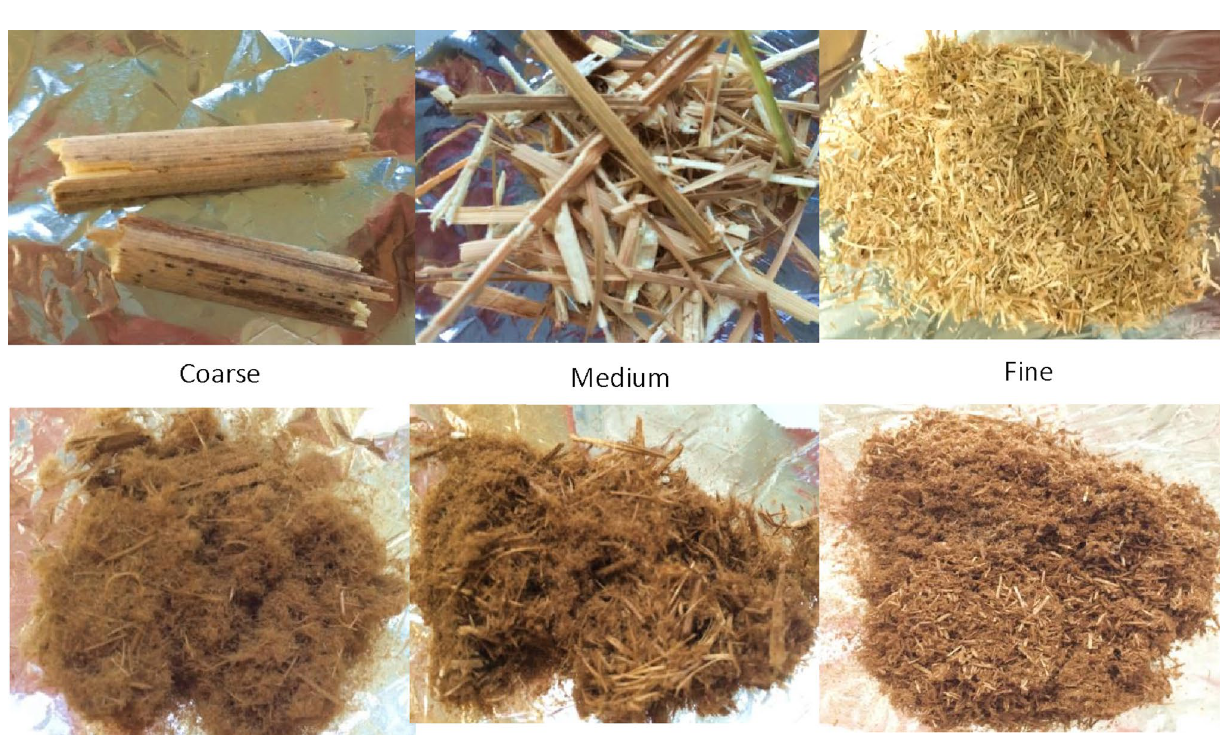
Figure 4. Photographs of (above) untreated biomass and (below) recovered pulps after pretreatment of Miscanthus with [TEA][HSO 4 ] at 120 °C for 6 h at bench scale using a biomass loading of 20 wt%.